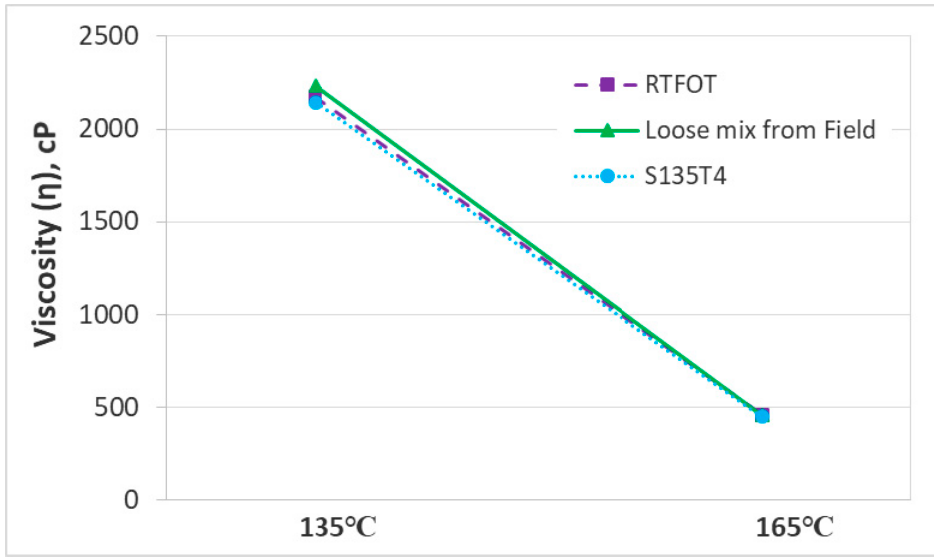
Figure 12. Comparison of viscosity results of modified binders recovered from mixture 3.